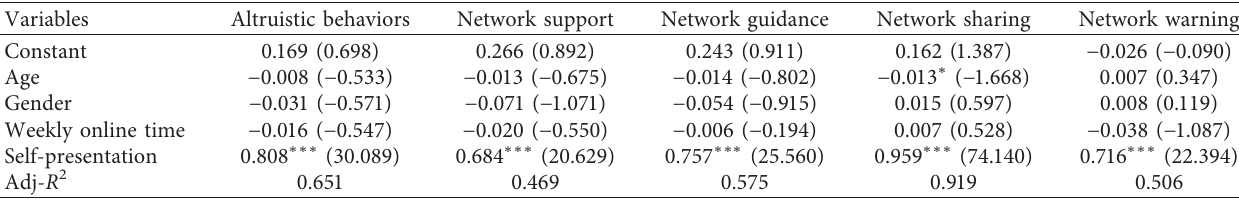
Table 2: Regression results of self-presentation and adolescent network altruistic behaviors.